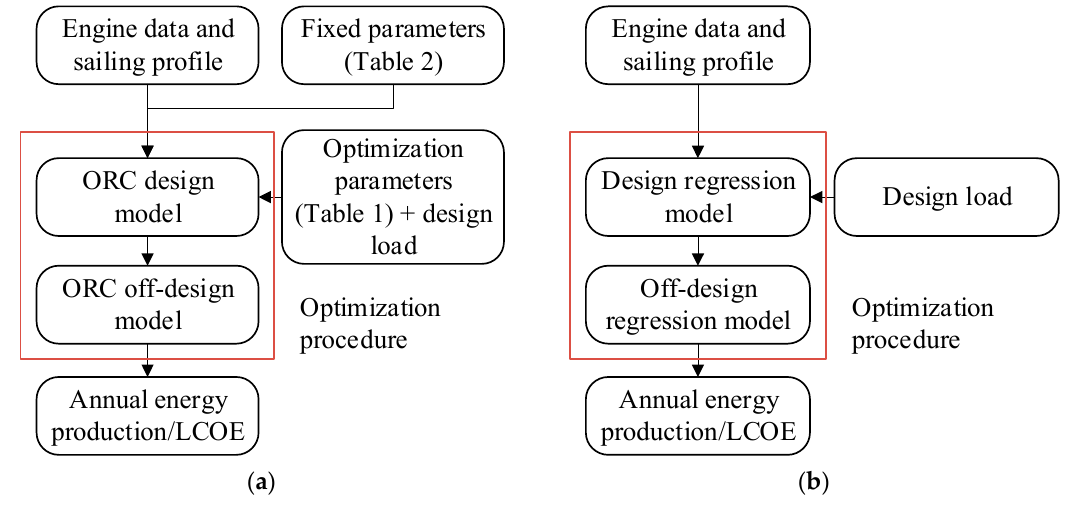
Figure 5. Procedure used to optimize the ORC annual energy production/LCOE: ( a ) thermodynamic models, ( b ) regression models.